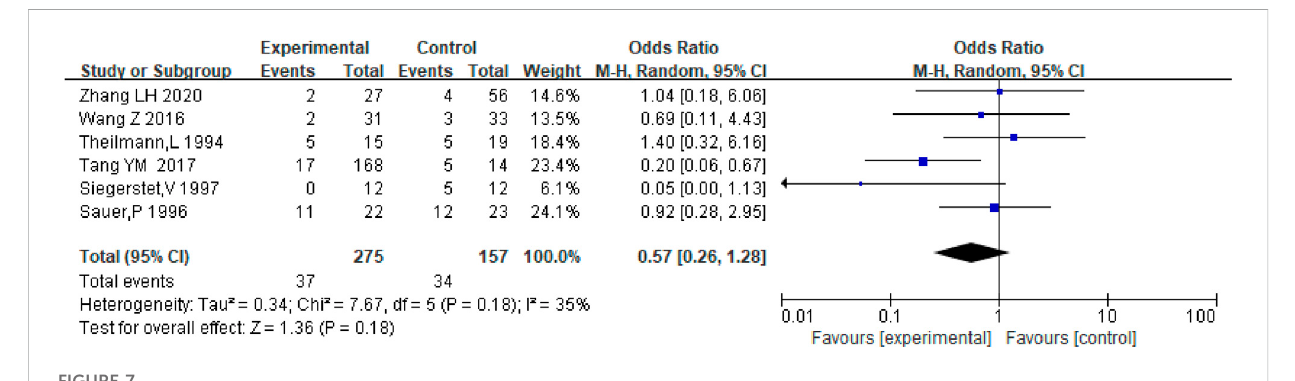
FIGURE 7 Effect of anticoagulation or antiplatelet treatment on stent dysfunction after TIPS.